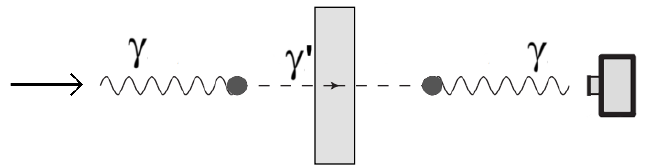
Figure 1 . Basic scheme of a LSTAW experiment. An incoming photon (cid:13) is converted into a DP (cid:13) 0 which interacts very weakly with the wall. It passes through the wall and is subsequently reconverted into an ordinary photon which can be